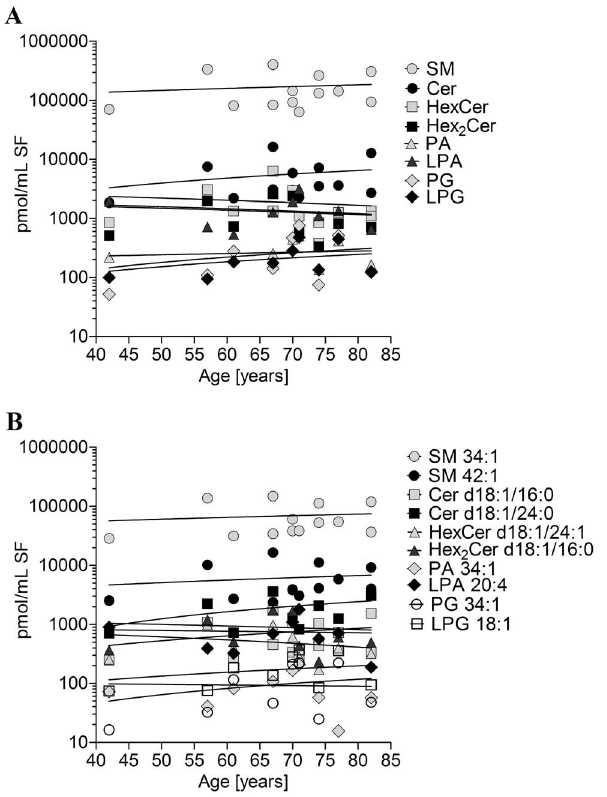
Figure 7. Concentrations of lipids in human synovial fluid as a function of the age of patients with late stage osteoarthritis. Lipids were determined by electrospray ionization tandem mass spectrometry (ESI-MS/MS) or liquid chromatography coupled with tandem mass spectrometry (LC-MS/MS) as outlined in Material and Methods . Values are displayed as a scatterplot of the concentration of each lipid class and species by age of donors. ( A ): Lipid classes, ( B ): Lipid species. SM-sphingomyelin, Cer-ceramide, HexCer-hexosylceramide (most likely glucosylceramide), Hex 2 Cer-dihexosylceramide (most likely lactosylceramide), PA-phospatidic acid, LPA-lysophosphatidic acid, PG- phosphatidylglycerol, LPG-lysophosphatidylglycerol.